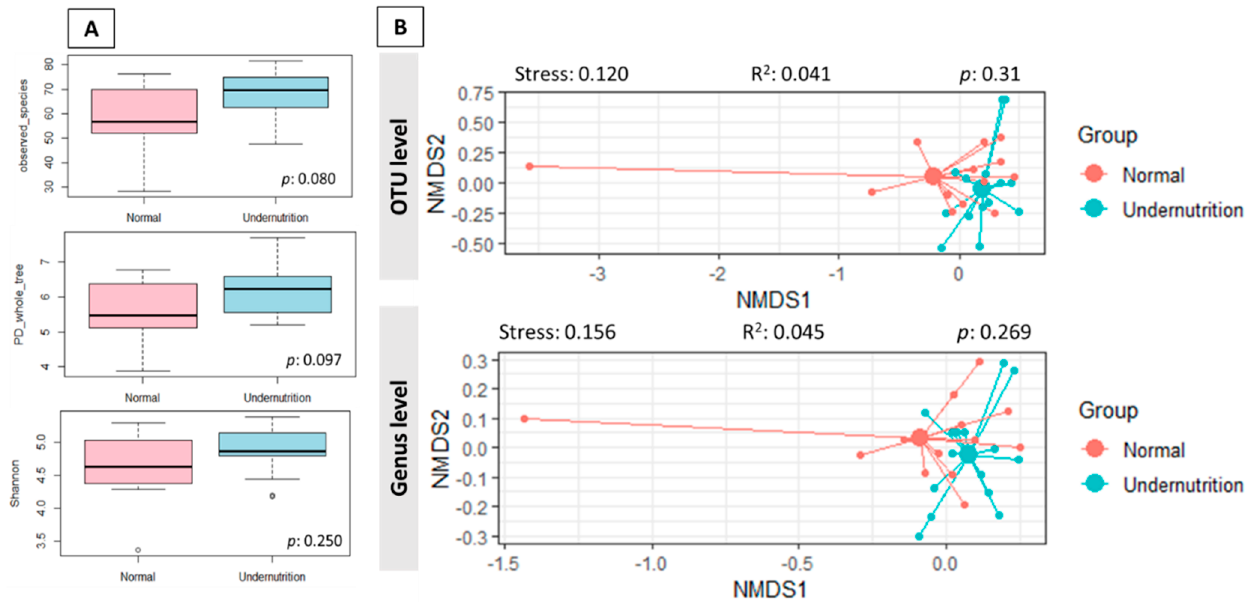
Figure 2. ( A ). Alpha diversity of gut microbiota between normal and undernutrition group. The difference between the group was analyzed using the Wilcoxon rank-sum test ( B ). The Bray–Curtis dissimilarity-based NMDS between normal and undernutrition group. Each data point in the graph stands for a sample. The distance between data points reflects the similarities between samples. The stress factor < 0.2 indicates the reliability of the result.